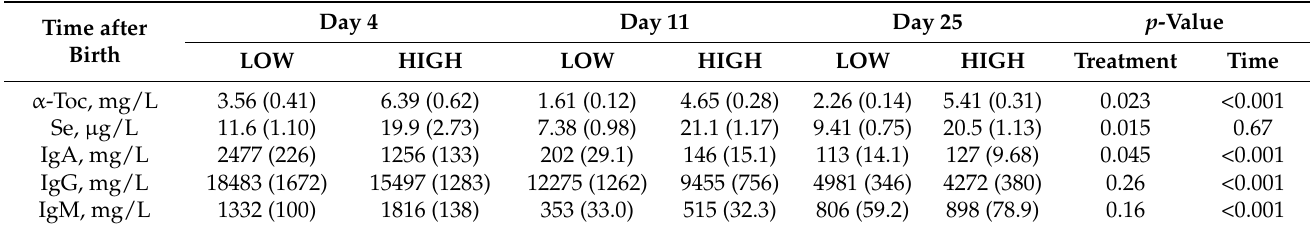
Table 2. Effect of maternal dietary antioxidant level on concentration of vitamin E ( α -Toc.), selenium (Se) and immunoglob- ulins (Ig) A, G, and M in plasma of off-springs (LOW: n = 26 piglets; HIGH: n = 27 piglets; means and standard error of mean